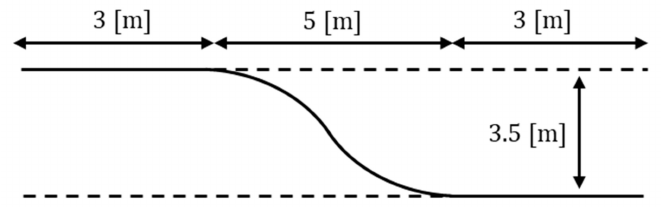
Figure 20. Lane-change path tracking scenario.